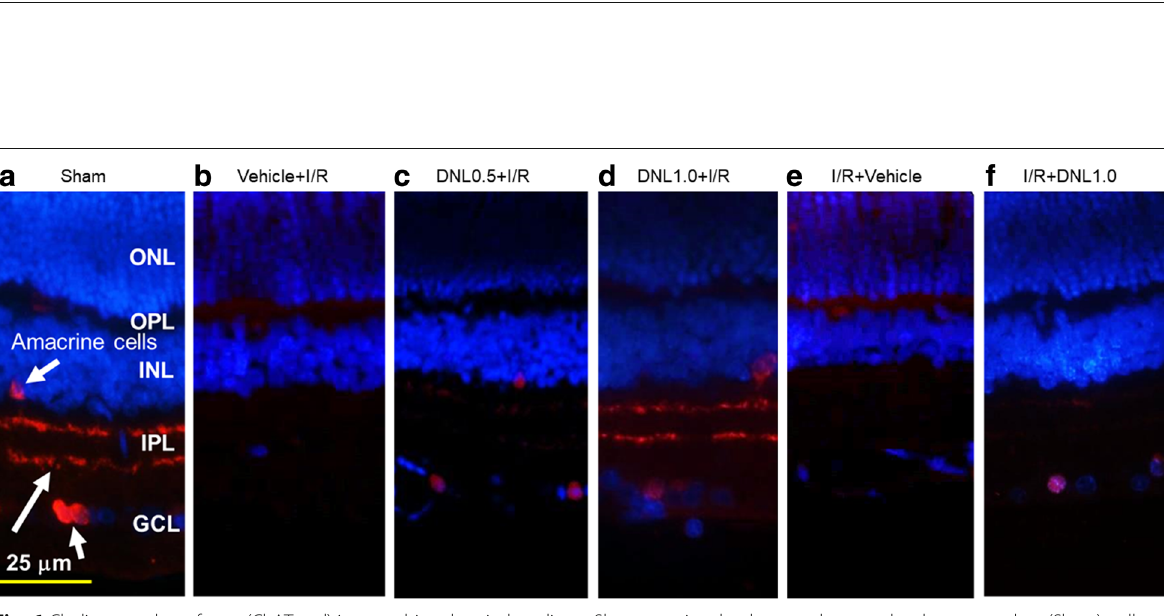
Fig. 6 Choline acetyltransferase (ChAT, red) immunohistochemical studies. a Shows a retina that have undergone the sham procedure (Sham); cell nuclei are counterstained with 4,6-diamidine-2-phenylindole dihydrochloride (DAPI, blue). Amacrine cell bodies (Sham; short arrows) can be seen in the INL and GCL and their neuronal processes (long arrow) display a two-band pattern in the IPL. b , e Show retinas that have undergone I/R together with pre − /post-administration of vehicle (Vehicle+I/R or I/R+Vehicle). A considerable reduction in the IPL immunoreactivity can be seen together with a great reduction in the number of amacrine cell bodies. c , d , f show sectioned retinas that have received I/R and pre-administration of 0.5 g/kg/day (c, DNL0.5+I/R), or 1.0 g/kg/day of DNL (d, DNL1.0+I/R), or that have received I/R and post-administration of 1.0 g/kg/day of DNL (f, I/R+DNL1.0). In these groups, the ischemia-induced changes can be seen to be obviously and dose-dependently mitigated when the ischemic retinas have received pre-administration of 0.5 and 1.0 g/Kg/day of DNL. Post-administration of 1.0 g/Kg/day of DNL can also be seen to obviously mitigate these ischemia- induced changes. Abbreviations: ONL, outer nuclear layer, OPL, outer plexiform layer, INL, inner nuclear layer, IPL, inner plexiform layer, GCL, ganglion cell layer. DNL, Dendrobium nobile Lindley. Scale bar =25 μ